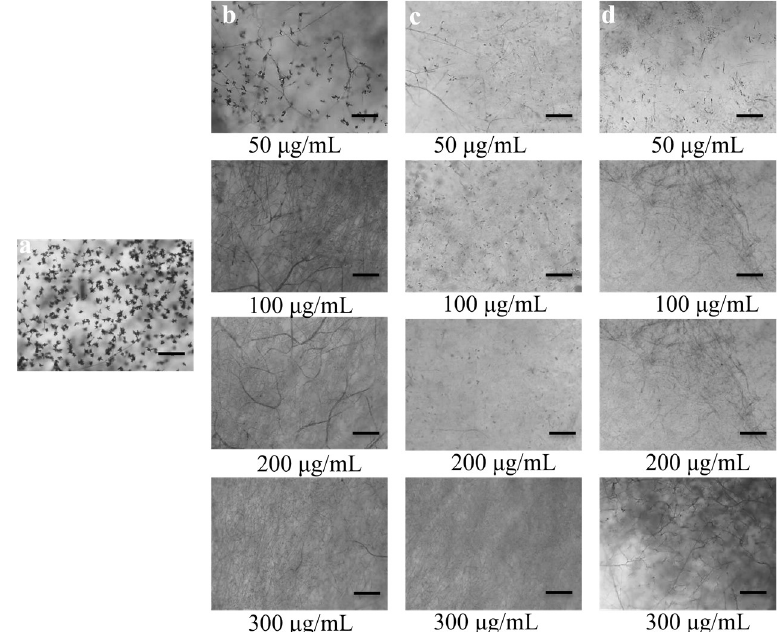
Figure 4. Effects of staurosporine, chelerythrine chloride, and the fungicide Nativo ® 75WG on inhibition of conidiogenesis of Magnaporthe oryzae Triticum in 96-multi-well plates at 50 µ g/mL, 100 µ g/mL, 200 µ g/mL, and 300 µ g/mL. ( a ) Profuse production of conidia on conidiophores (conid- iogenesis) in untreated control. Suppressed conidiogenesis by varying doses of staurosporine ( b ), chelerythrine chloride ( c ), and Nativo ® 75WG ( d ). Bar = 50 µ m.